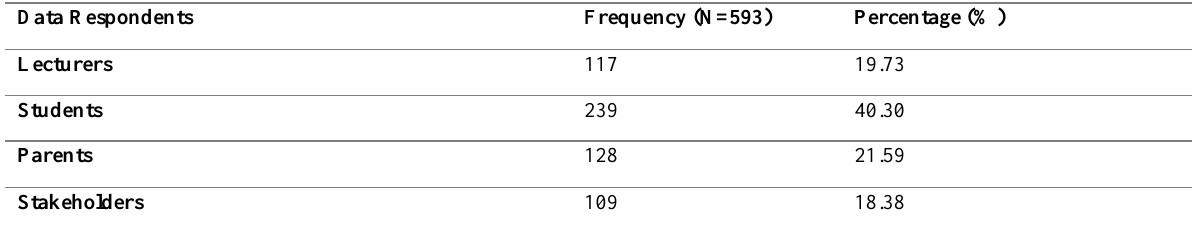
Table 1: The Respondent